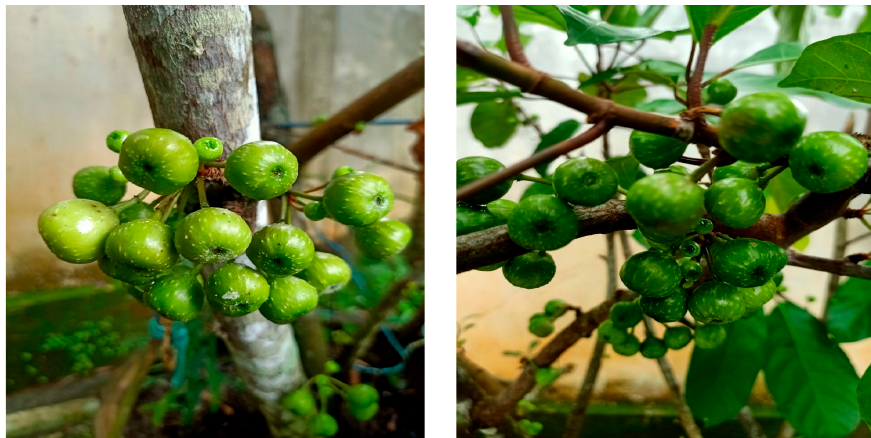
Figure 1. Duea ching plant bearing fruits.